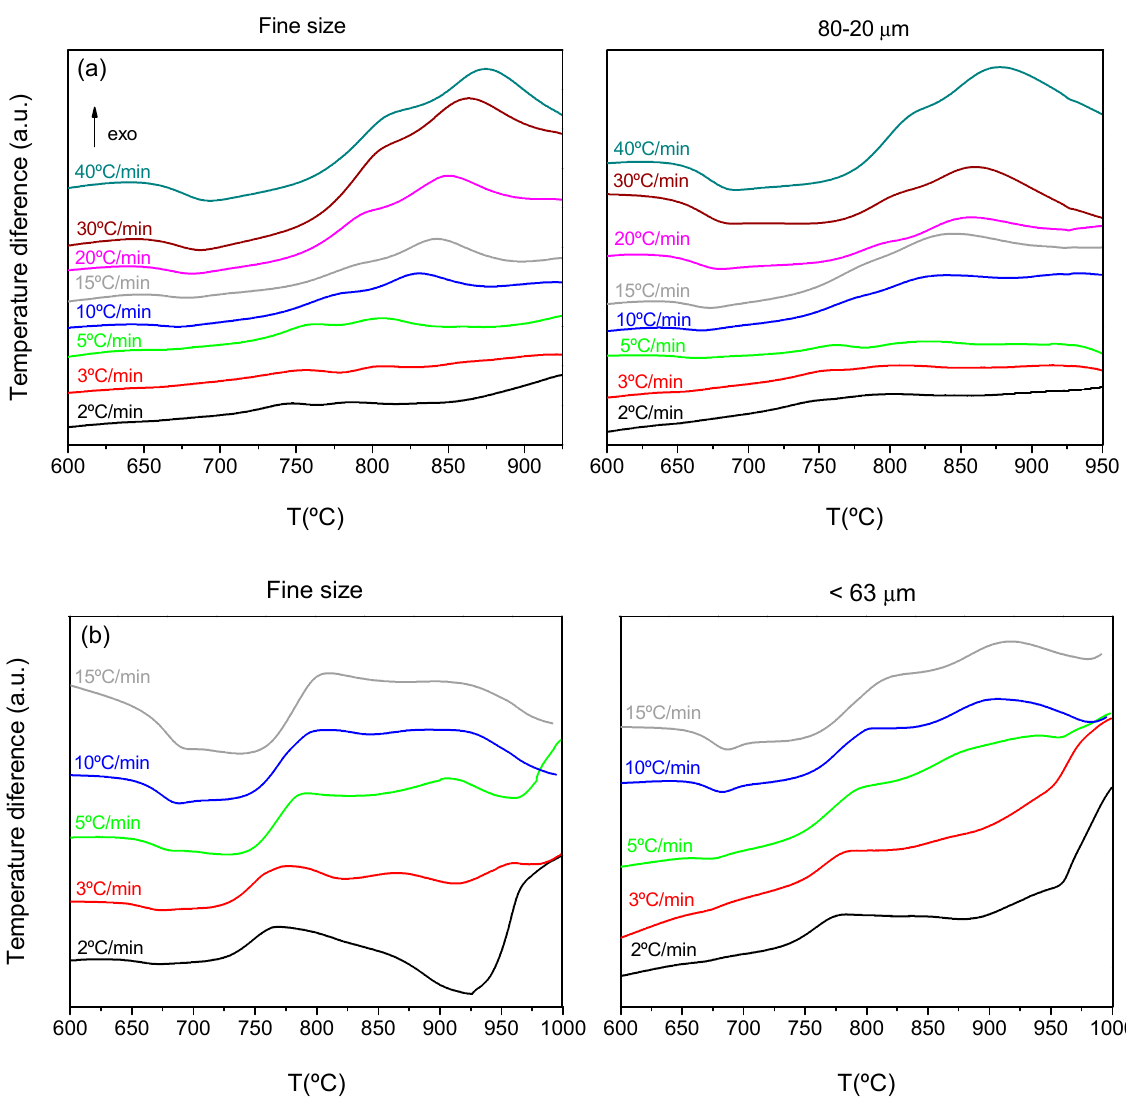
Figure 3. DTA curves for ( a ) 7.5B(Ba) and ( b ) 10B(Sr) compositions at different heating rates. The DTA curves provided the characteristic temperatures, which are represented in Table 4. There is a wide peak of crystallization with two maxima, which indicate the presence of two crystallization peaks occurring at similar temperatures. For the calculation of each peak temperature, the signal was adjusted to two Gaussian peaks and the maximum of each gaussian was taken as the peak temperature, T p1 and T p2 in Table 4. When increasing the heating rate, all the crystallization temperatures shifted to higher temperatures. The nucleation time decreased with higher heating rates, reducing the nuclei formation and further crystallization and leading to crystallization peaks appearing at higher temperatures [25,26]. The particle size had a similar effect on the temperatures, so when increasing the particle size, the crystallization peaks shifted to higher